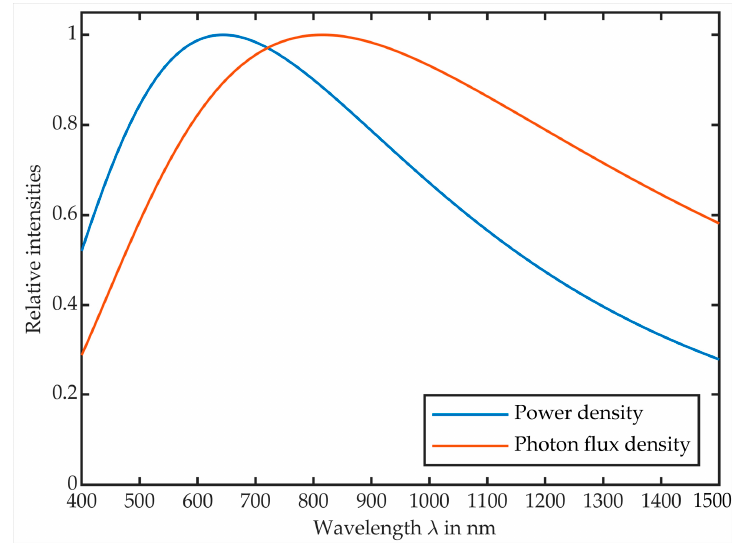
Figure A1. Spectral power density and photon flux density for thermal emission at T = 4500 K.